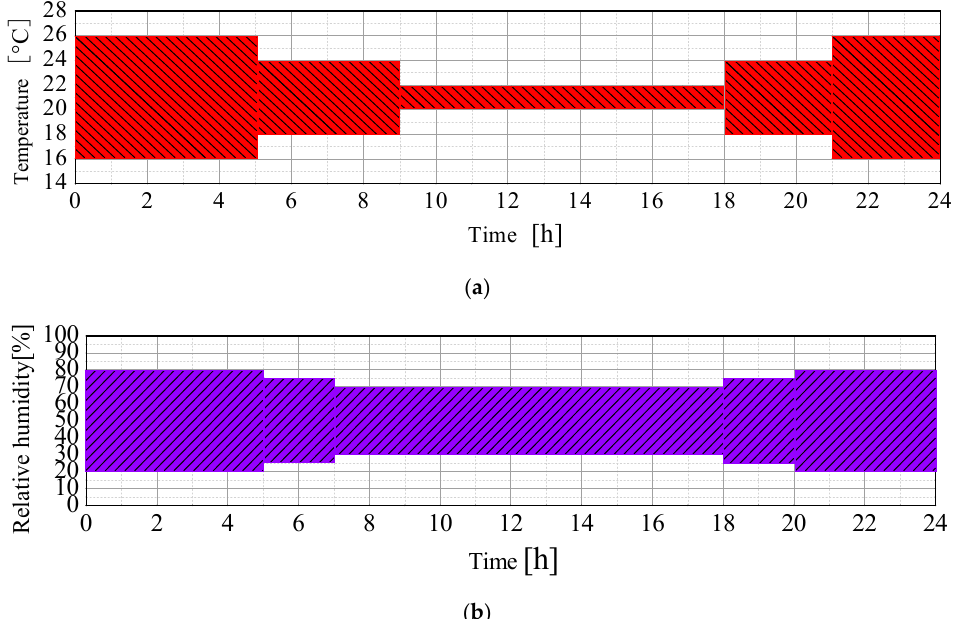
Figure 4. Temperature and relative humidity of the controlled office hourly in working time. ( a ) Temperature controlling method; ( b ) relative humidity controlling method. Table 6. Air conditioning running time in different